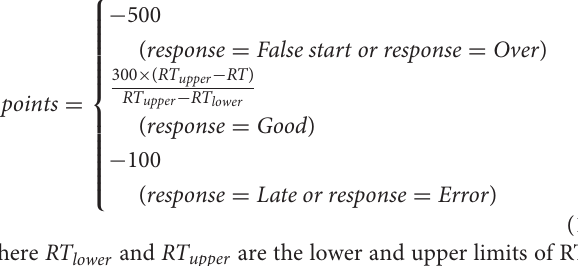
interval from the feedback end to the beginning of the next trial was randomly set from 2,000 to 2,500 ms. The interval was chosen to avoid contamination of feedback-related components with the baseline time region for ERP calculation. Participants were instructed to avoid blinking as much as possible during the period from the onset of a pre-cue to the onset of feedback to avoid contaminating EEG data with eye-related